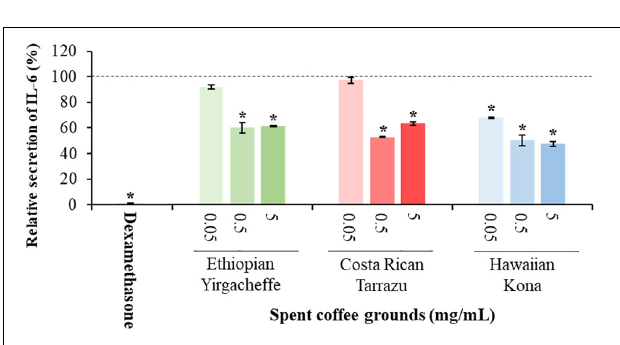
FIGURE 2 | Effect of spent coffee ground extracts on the secretion of TNF- α by PMA-differentiated, LPS-stimulated U937 cells. Dexamethasone was used at 0.2 µ g/mL as a positive control. (*) Significant decrease ( p < 0.001) compared to PMA-differentiated, LPS-stimulated U937 cells in the absence of extract. Mean ± SEM.